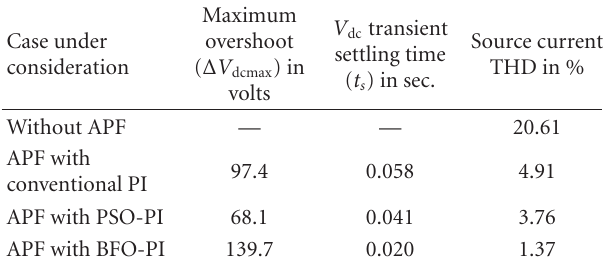
Table 3: APF response comparison for unbalanced supply condi-